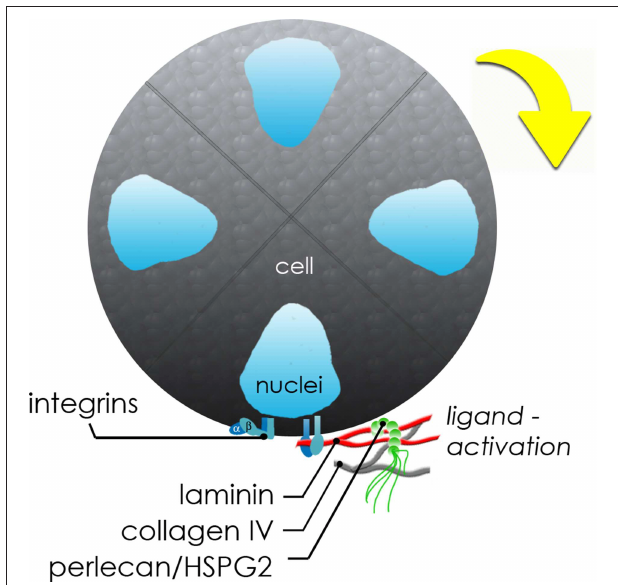
FIGURE 7 | Schematic of molecular interplay during de novo microstructure organization. Secreted basement membrane proteins are directionally secreted and organized by hS/PCs at the periphery of the growing microstructure. The initial growth and coordinated movement during this maturation phase depends on β 1 integrin activation by hS/PC-secreted ligands: laminin, collagen IV, and perlecan/HSPG2. Adhesive interactions between integrins on cells and matrix or hydrogel networks surrounding them can generate traction forces large enough to drive coordinated revolutions of entire multicellular